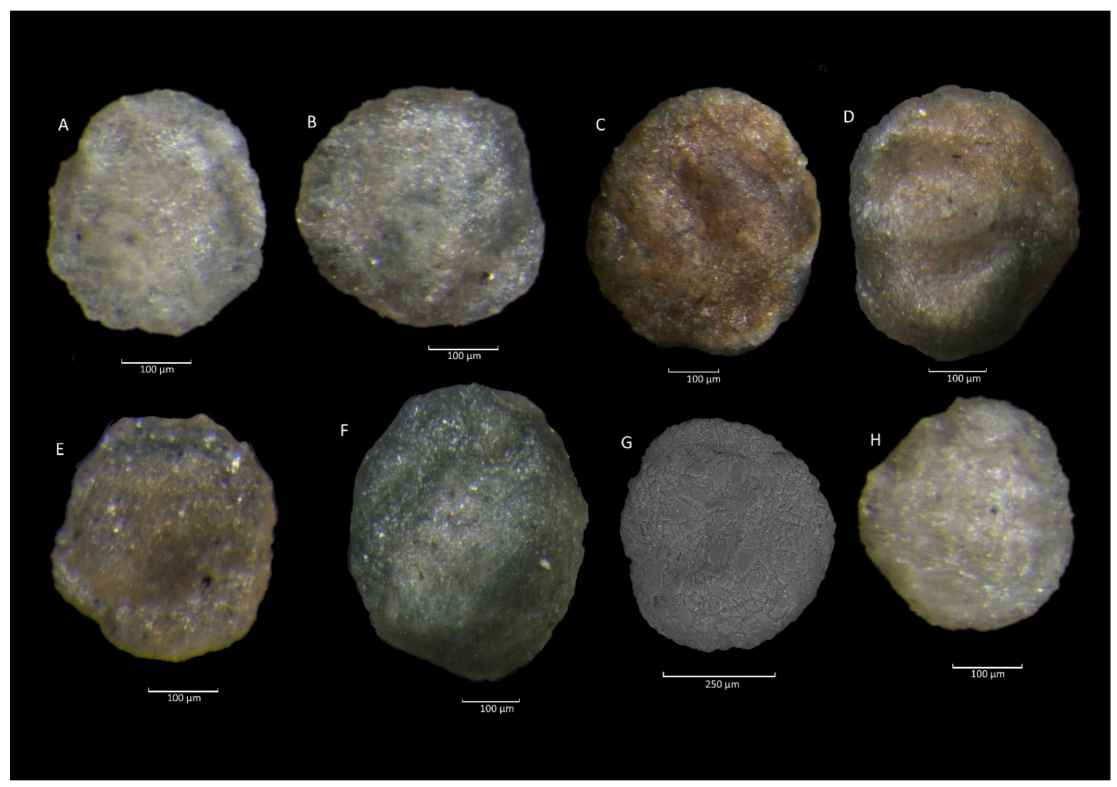
Figure 12. Praesphaerammina gerochi (Hanzl í kov á ). ( A , B , E ): Kamesznica section; ( C , D ): Istebna section; ( F , H ): Bła˙zowa section; ( G ): Nowica